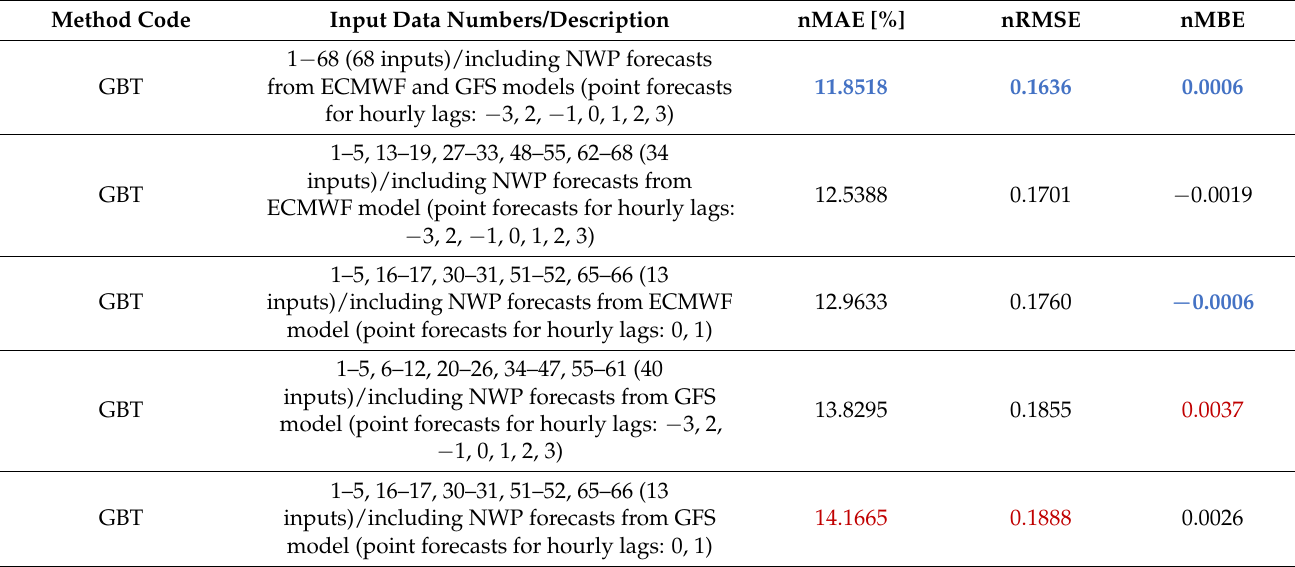
Table 7. Measures of performance of the proposed GBT method, with different versions of NWP input data (test subset) for Wind Farm A.